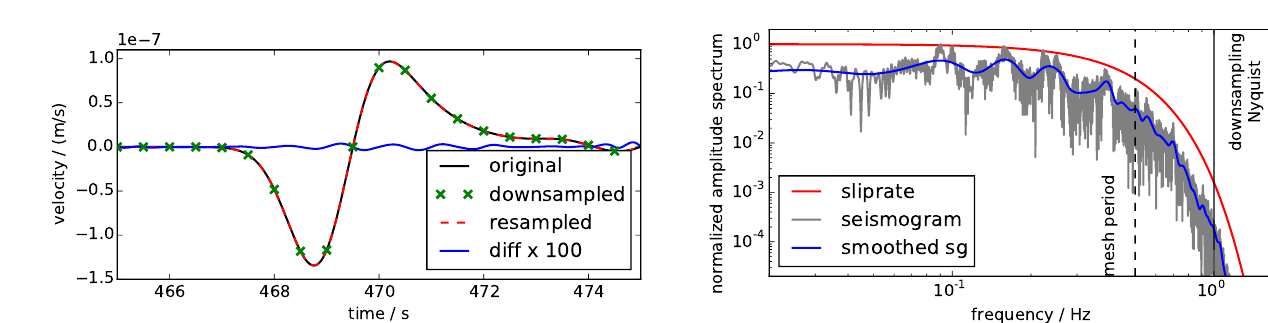
Figure 9. Resampling using a Lanczos kernel with a = 12 of a P ar- rival velocity seismogram convolved with the source time function from Fig. 11 recorded at 40 ◦ distance, and the resampling error mul- tiplied by a factor of 100. The relative error is on the order of 0.05% of RMS, see Fig. 10.